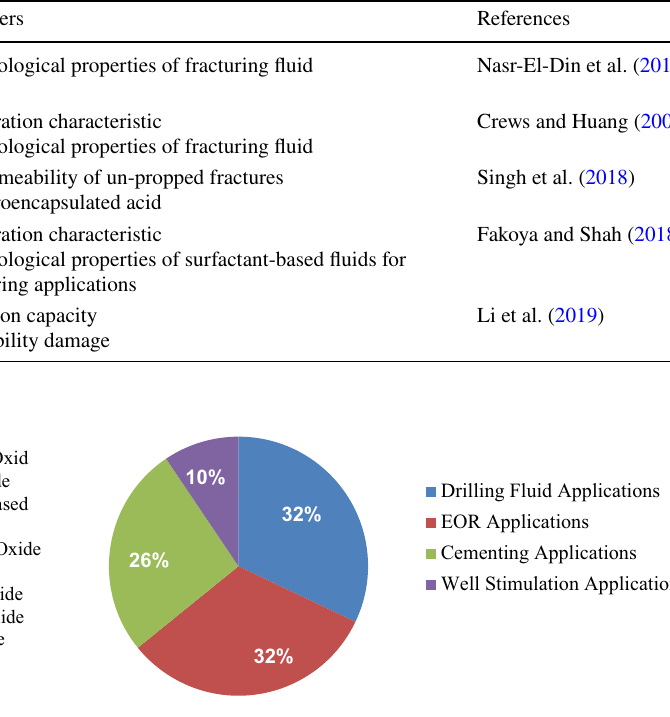
Fig. 4 Percentage of the conducted investigations of nanoparticles across the oil and gas